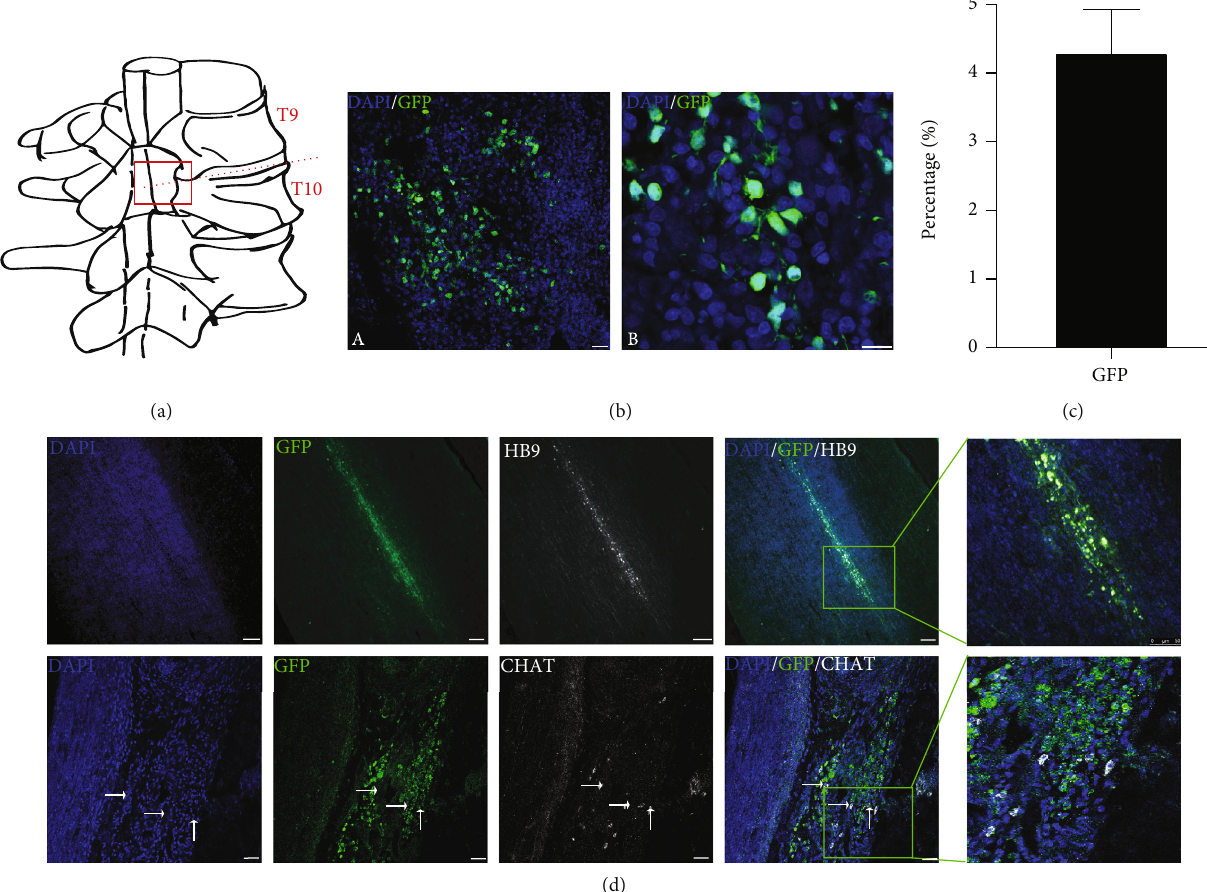
Figure 7: Survival and di ff erentiation of iNSC-derived motor neuron progenitors transplanted into the spinal cord of rats. (a) Schematic diagram of transplantation sites in rat spinal cord. (b) The GFP-positive surviving grafts two weeks following transplantation into the spinal cord. Scale bars, 100 μ m. (c) The proportion of GFP-positive surviving cells. (d) Two weeks after transplantation, GFP-positive grafts were detected at the spinal cord that were also HB9- or CHAT-positive. Scale bars, 100 μ